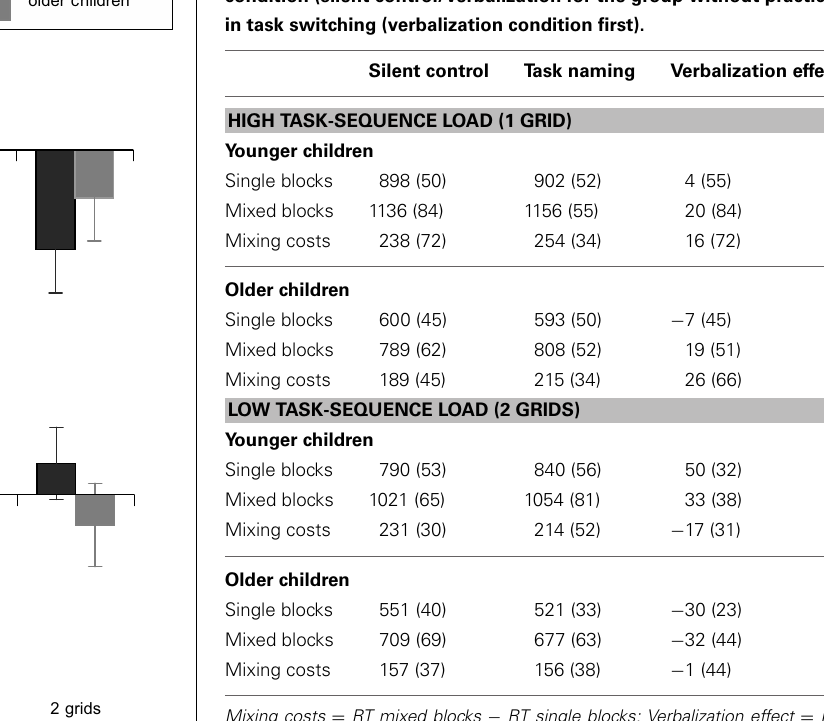
Mixing costs = RT mixed blocks − RT single blocks; Verbalization effect = RT task naming − RT silent control condition. Positive values of difference scores indicate costs and negative values